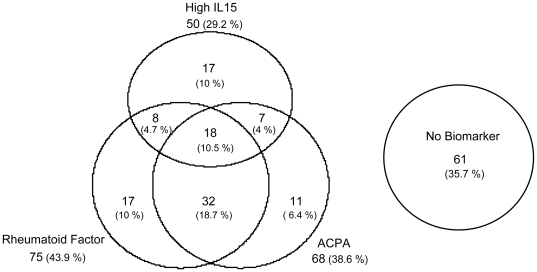
Distribution of rheumatoid factor (RF), anti-cyclic citrullinated peptide antibodies (ACPA) and/or high sIL-15 levels (sIL-15) in the population of patients with Early Arthritis.Data are shown as Venn diagrams whose circle size has been adjusted to represent, albeit not exactly, the number of patients with each combination of markers. The raw number of patients is displayed larger than the percentages that appear in brackets. The total number of patients is 171, although since some patients exhibited combinations of markers, the sum of the number of patients under the name of the biomarkers exceeds this figure.